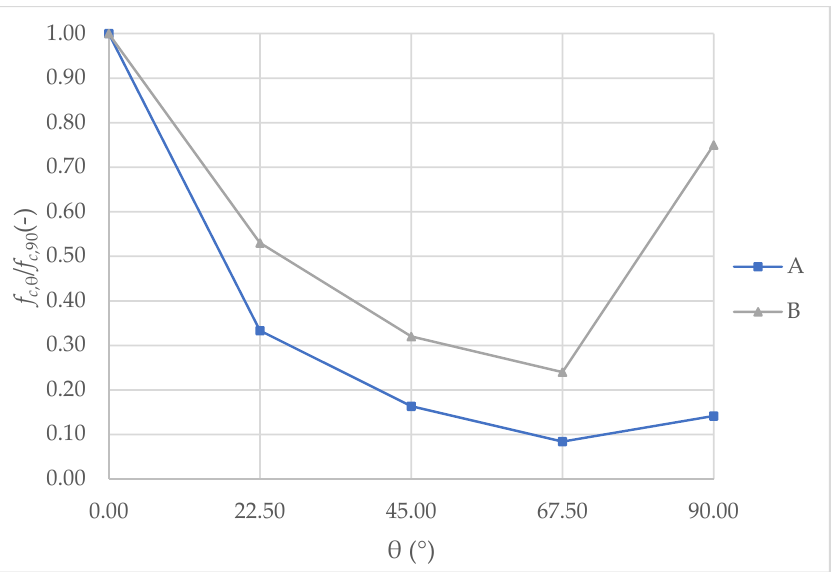
Figure 14. Changes in relative compressive strength f c , θ / f c ,0 in regard to angle θ of A— hollow clay blocks in biaxial compression based on [35], B—walls of tested clay bricks.